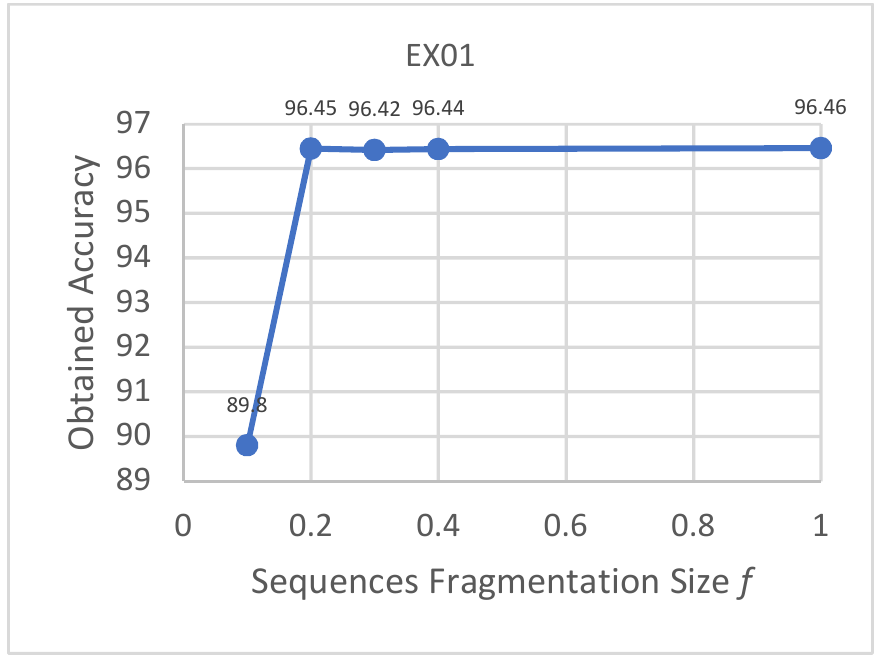
Figure 10. The reported accuracy scores upon sequence fragmentation (f = 0.1, 0.2, 0.3, 0.4, 1) of applying Model_I to Dataset_VI (EX01).